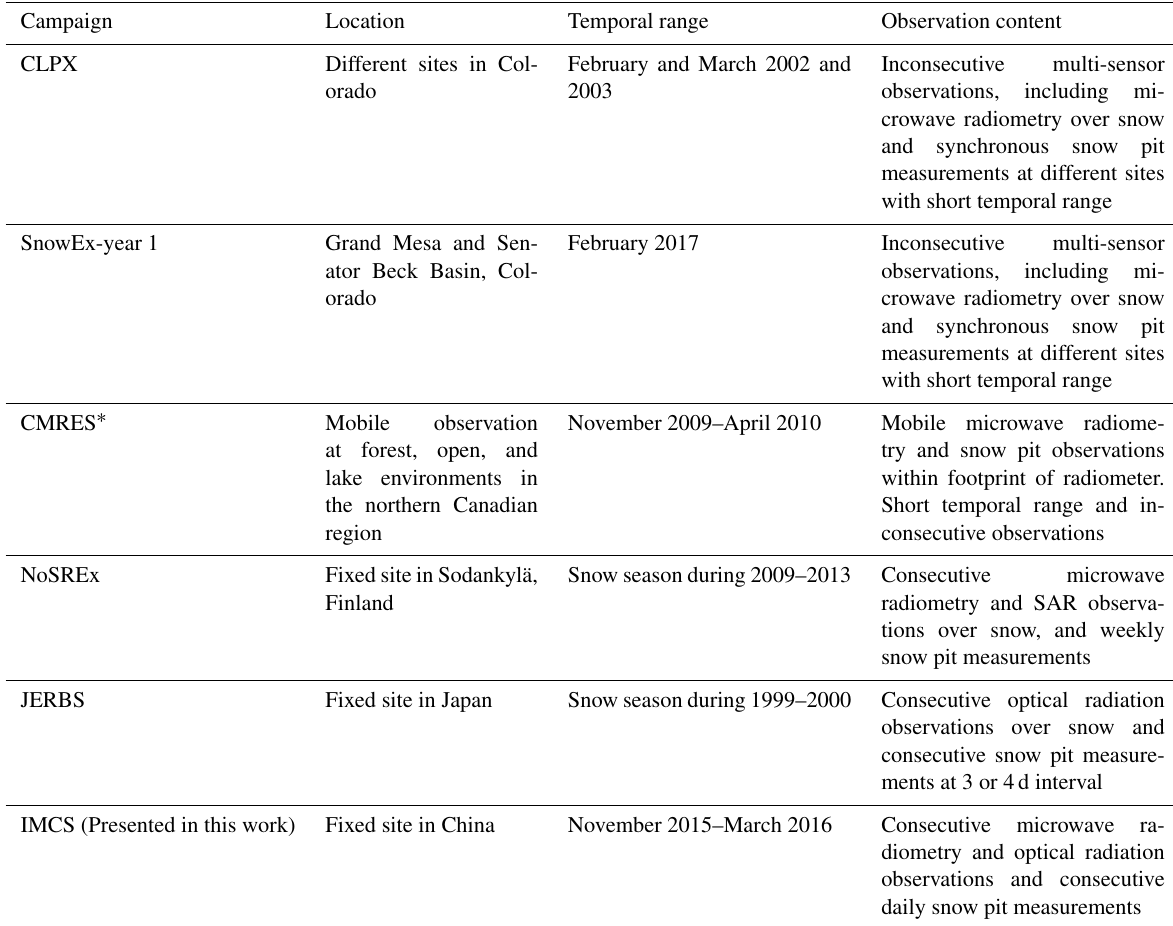
Table 1. Summary of existing experiments for microwave and optical radiation and physical features of snowpack.